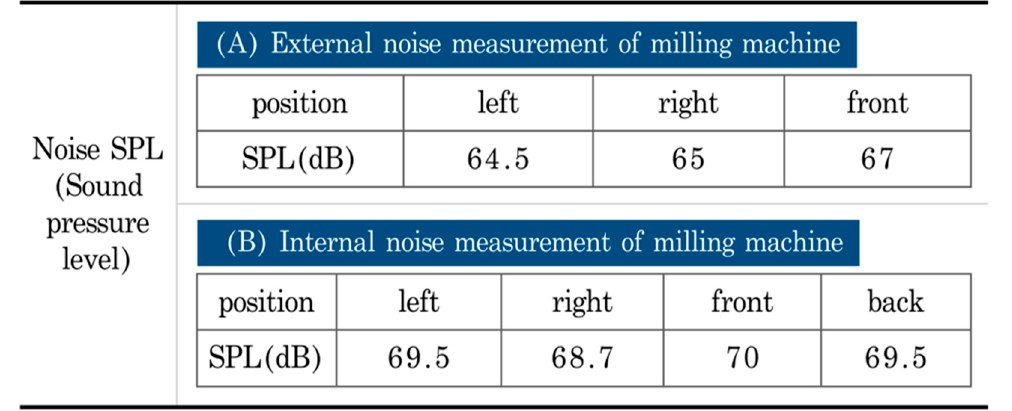
Figure 4. Noise level of the milling machine (SPL = sound pressure level). ( A ) external noise; ( B ) internal noise.